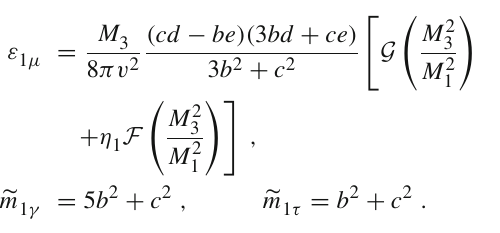
for leptogenesis to be viable as func- 1 < M < M ( M 1 2 2 1